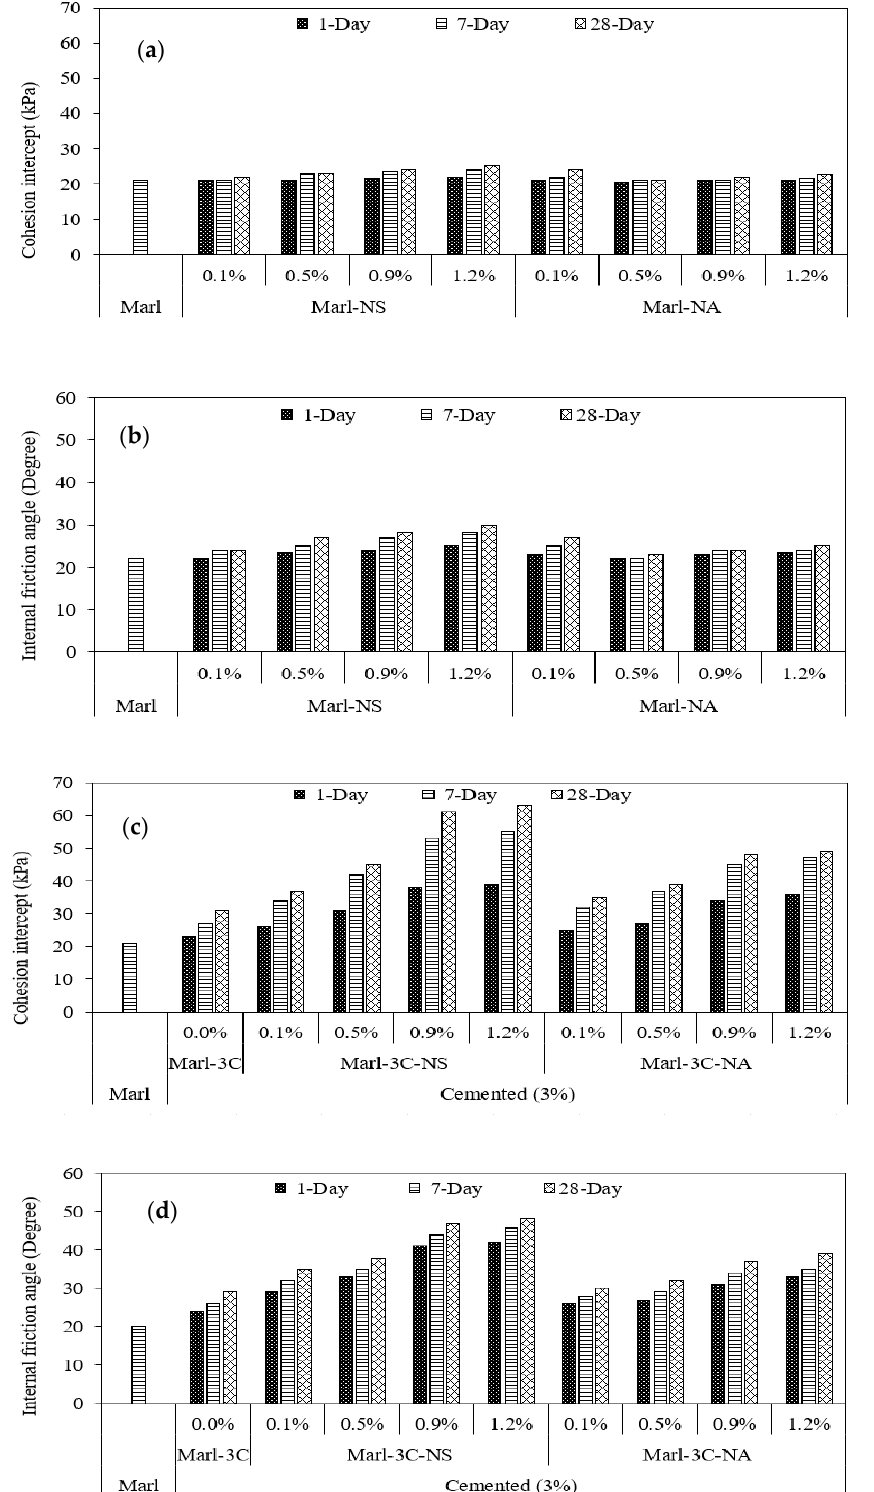
Figure 6. The shear strength parameters of stabilized marl: ( a ) cohesion intercept of nano-additive stabilized marl; ( b ) internal friction angle of nano-additive stabilized marl; ( c ) cohesion intercept of nano-additive+cement stabilized marl; ( d ) Internal friction angle of nano-additive+cement stabilized marl.